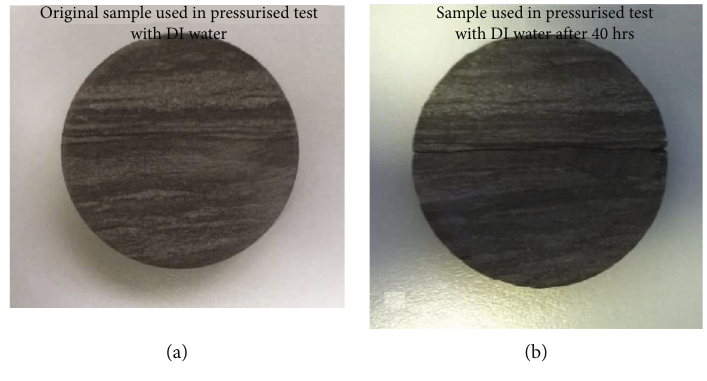
Figure 9: Testing results from